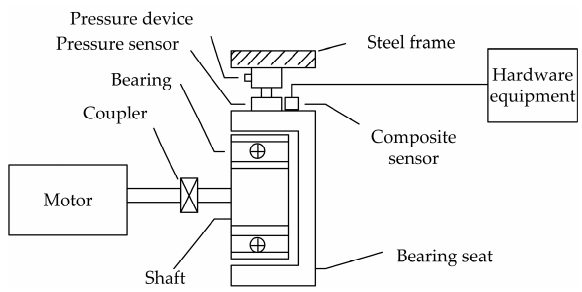
Figure 3. Schematic diagram of the test platform.